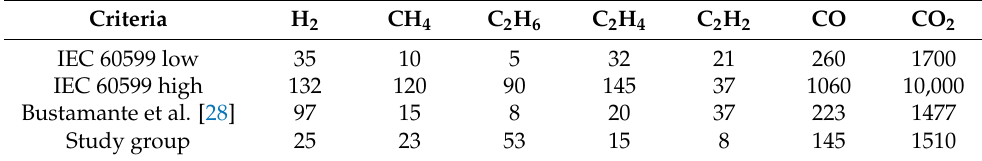
Table 4. The 90th percentile values of gas level increase between successive sampling in ppm/year.